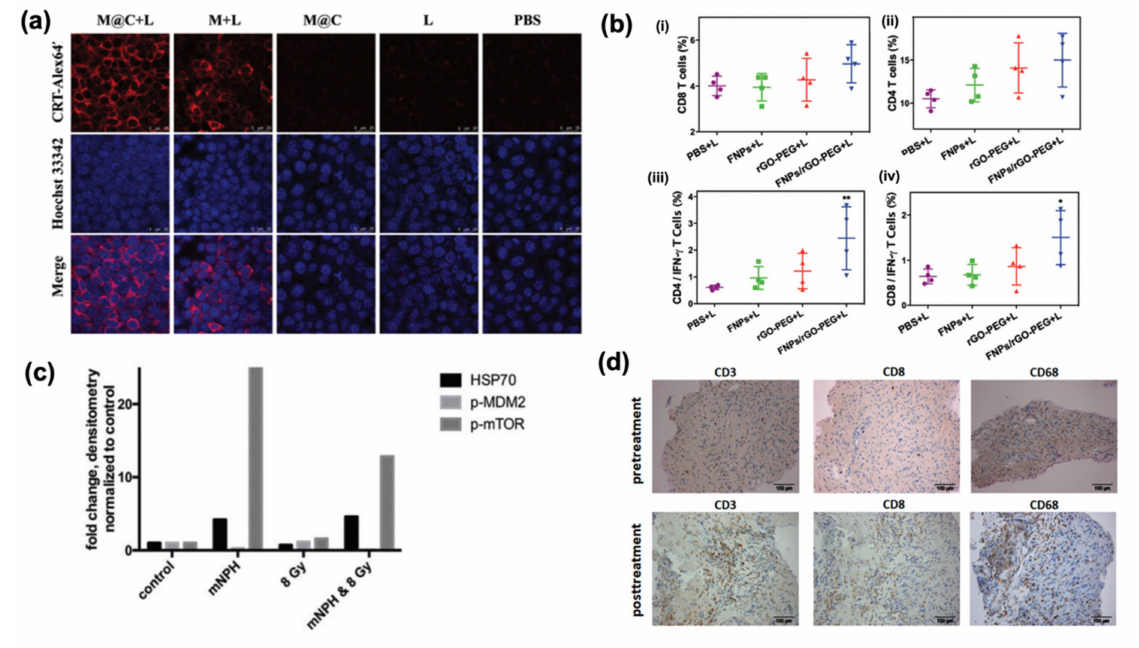
Figure1. Immunogeniceffectsofhyperthermiatreatment. ( a )Analysisoftheexpressionofsurface-exposed calreticulin after treating 4T1 cells with melanin nanoparticles (reproduced with permission from Chemical Communications , published by Royal Society of Chemistry, 2020) [15]; ( b ) T cell subpopulations found in spleens of 4T1 tumor-bearing mice treated with reduced-graphene oxide hybridized iron oxide nanoparticles (reproduced with permission from Journal of Materials Chemistry B , published by Royal Society of Chemistry, 2020) [16]; ( c ) Expression of immunogenic factors evaluated after combined hyperthermia with magnetic nanoparticles and radiotherapy in B16 murine melanoma cells [18]; ( d ) Para ffi n-embedded tissue sections stained for T cell subpopulations taken from patients treated with hyperthermia using superparamagnetic iron oxide nanoparticles